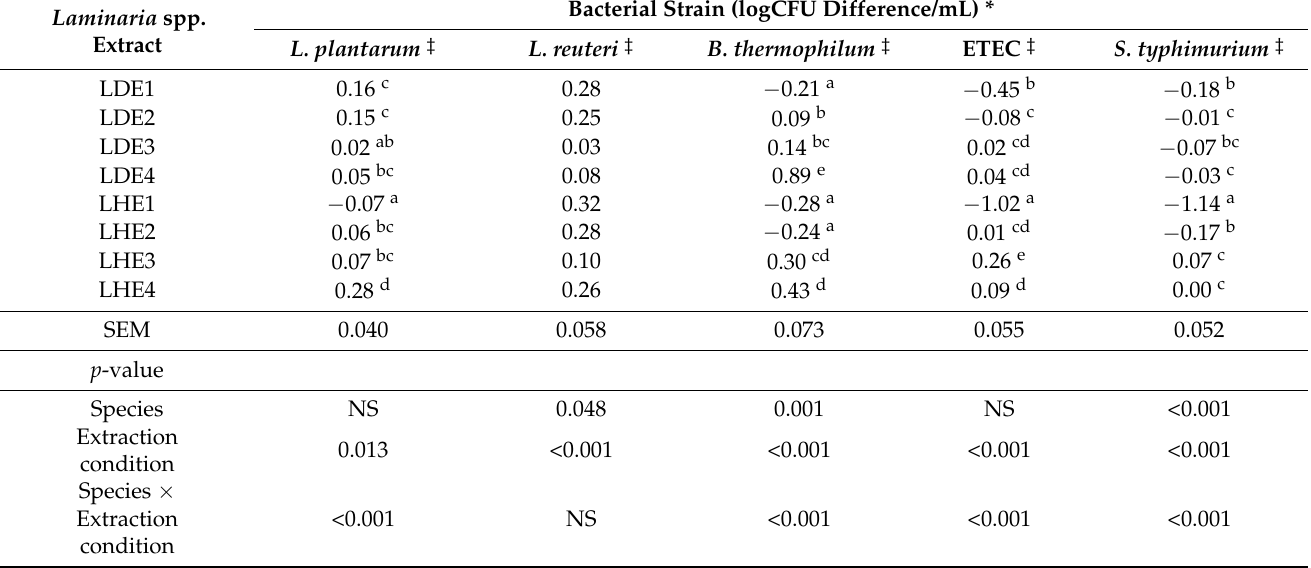
Table 7. Effects of seaweed species and extraction conditions on the antibacterial and prebiotic potential of the L. digitata and L. hyperborea extracts in the pure-culture growth assays (least-square means and standard error of the